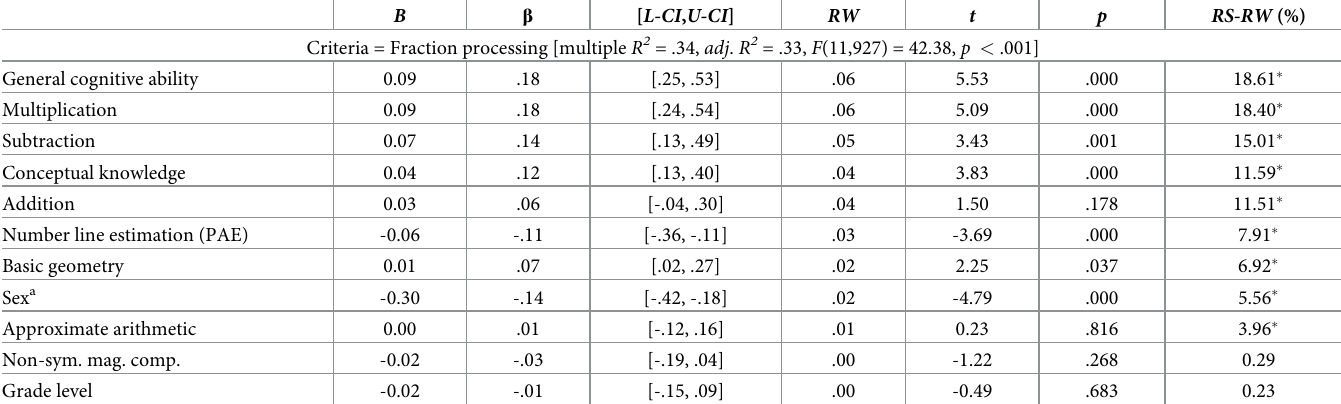
42.38, p < .001]. Seven variables significantly predicted performance in the fraction processing test: general cognitive ability, number line estimation, subtraction, conceptual knowledge, multiplication, basic geometry and sex (see Table 3). Inspection of beta weights indicated that Table 3. Multiple regression and relative weight